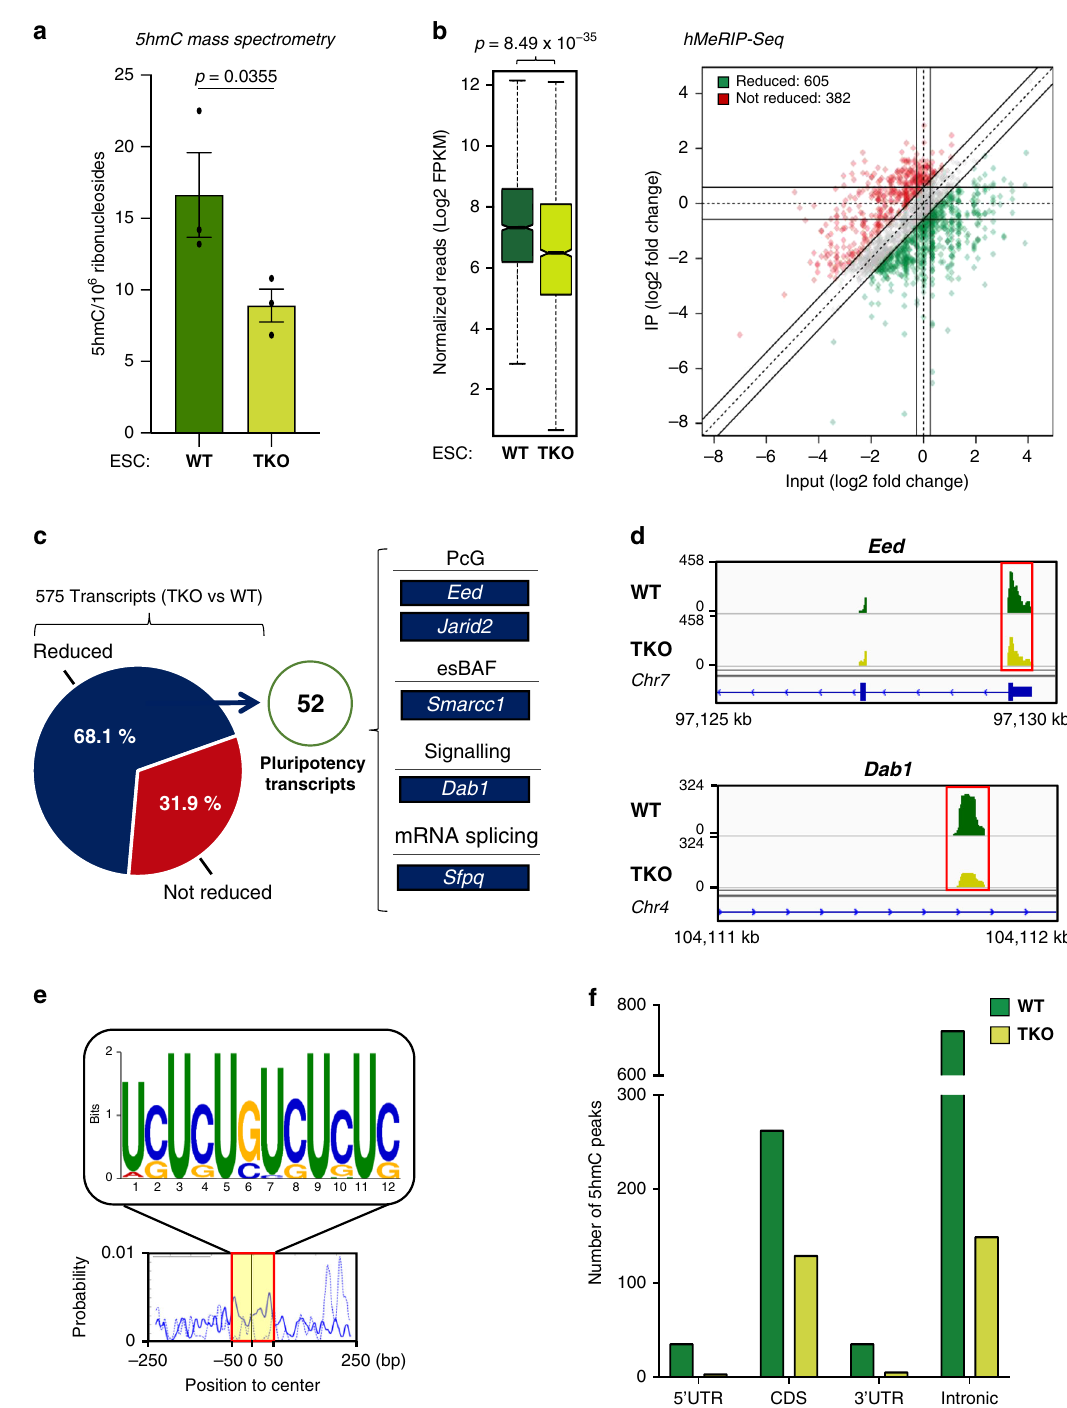
Fig. 2 Tets are required for 5hmC in ESCs, notably of key pluripotency-related mRNAs. a Reduced global 5hmC in TKO ESCs, as measured by mass spectrometry. Data are means ± SEM ( n = 3 independent experiments, one-tailed Student ’ s t -test). Source data are provided as a Source Data File. b Decreased 5hmC at many peaks in TKO ESCs. Left: Box plot showing a signi fi cant difference in the normalized number of 5hmC reads between WT and TKO ESCs ( n = 3 independent experiments, one-tailed Student ’ s t -test). In the box plot, the boxes represent the interquartile range of the records, and the lines across the boxes indicate the median value of the records. The whiskers indicate the highest and lowest values among the records that are no more than 1.5 times greater than the interquartile range. The range between notches represents the 95% con fi dence interval. Right: Quadrant chart showing differential 5hmC peaks in WT vs TKO ESCs. c Tet-mediated 5hmC marking of core pluripotency transcripts. Pie chart highlighting the percentage of transcripts whose 5hmC marking appears reduced, 52 of which are known to be involved in pluripotency. d Exemplative hMeRIP-Seq pro fi les of Eed and Dab1 in TKO vs WT ESCs (IGV tracks) (red frame shows peak location). e Top sequence motif identi fi ed at the centers of 5hmC peaks reduced in WT vs TKO ESCs ( E -value < 3.9e − 086). f Non-random distribution of Tet-mediated 5hmC marking. Bar chart showing, in WT and TKO ESCs, distinct distributions of 5hmC peaks among types of structural elements within